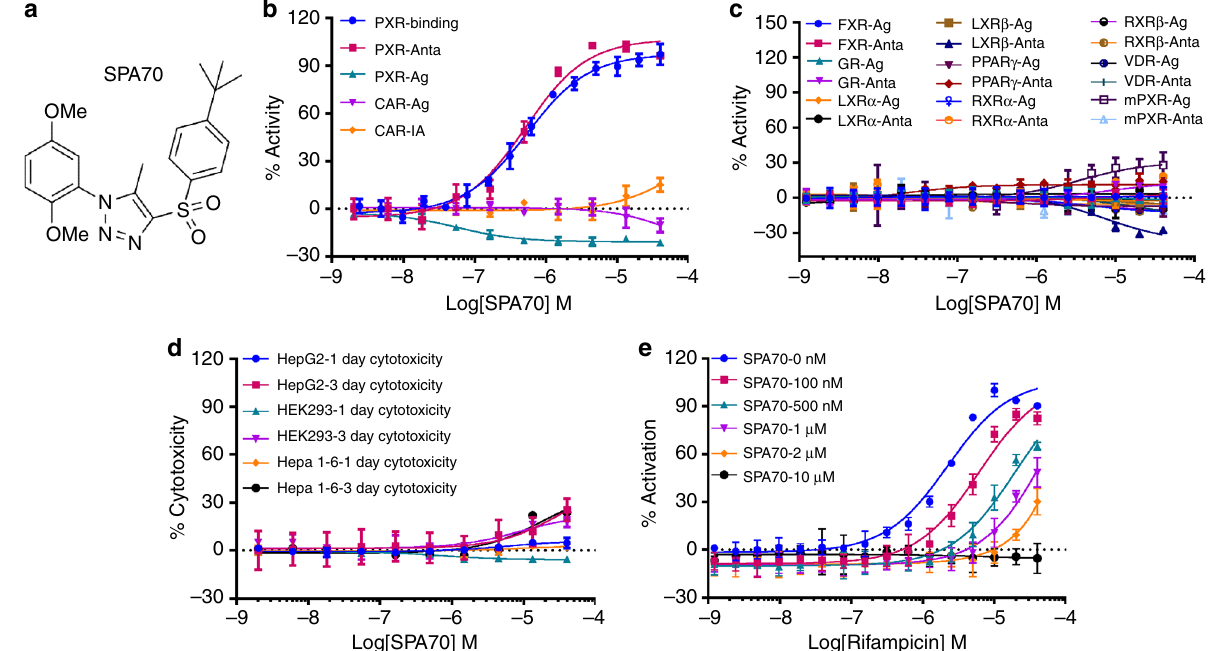
Fig. 1 SPA70 is a speci fi c hPXR antagonist. a Chemical structure of SPA70. b – d Dose – response curves of SPA70 in various assays. b PXR-binding: